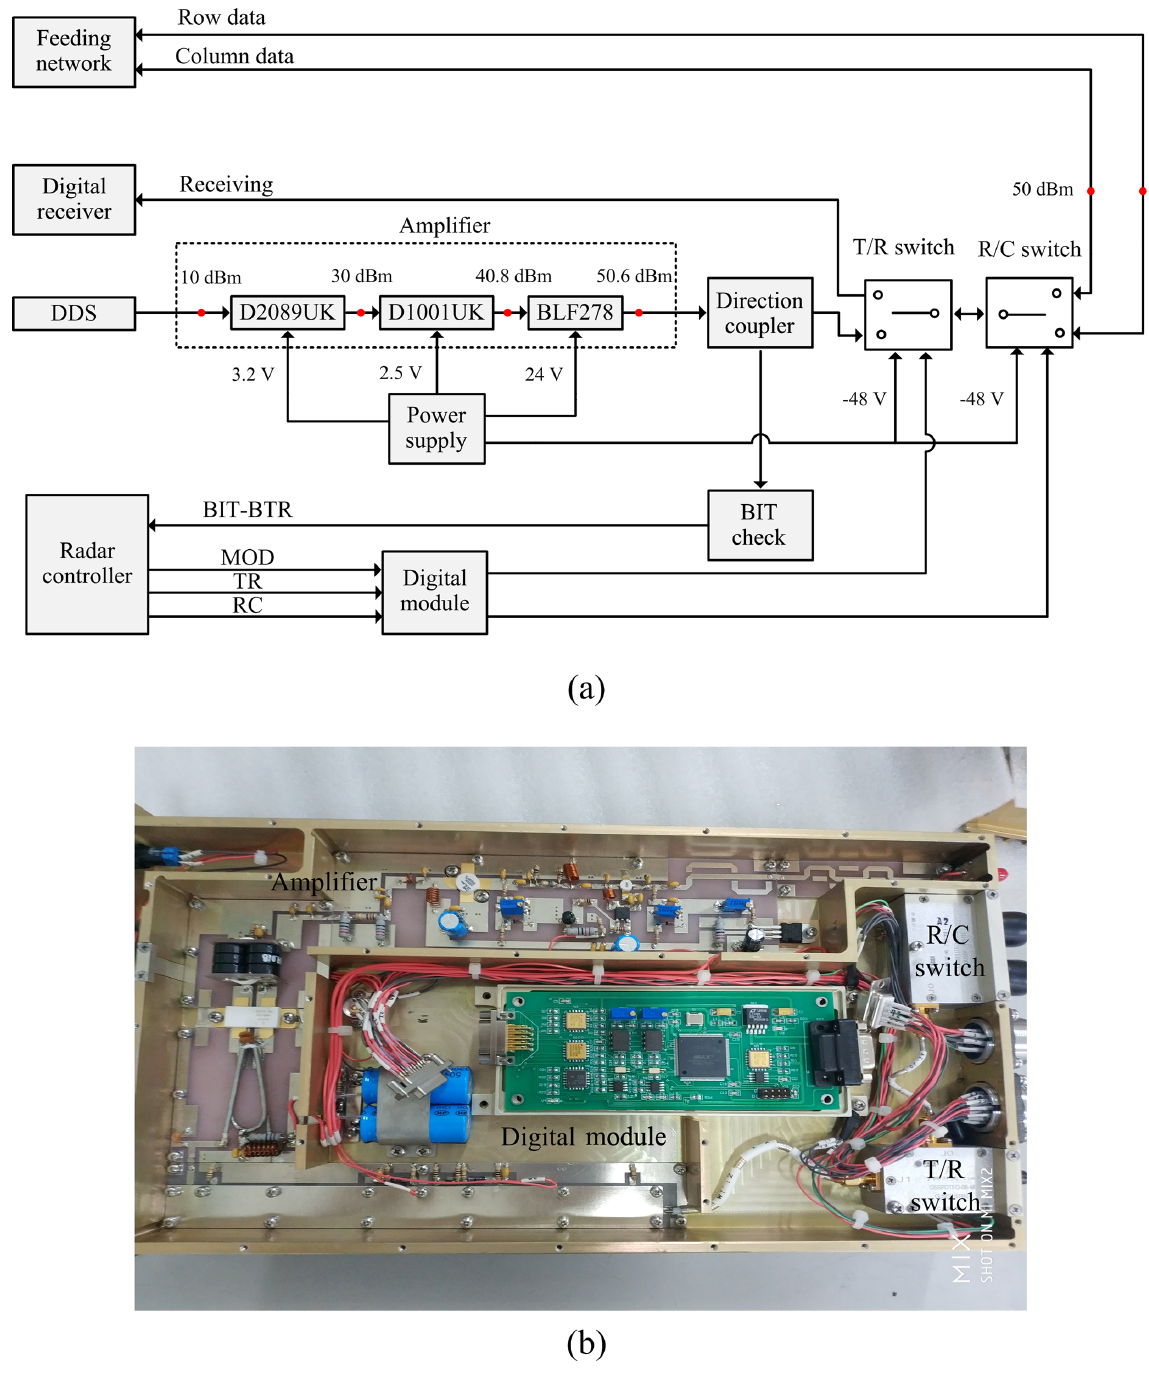
Figure 4. Block diagram (a) and photograph (b) of the big TR module.